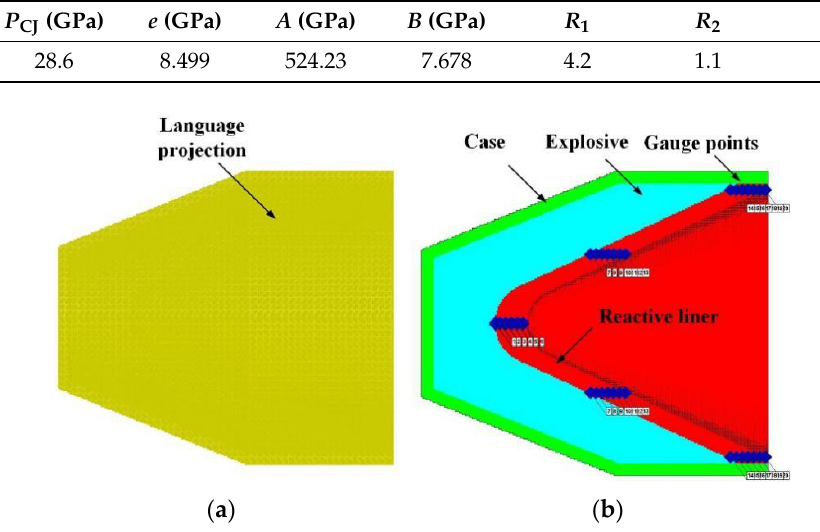
The main charge is the 8701 explosive, and its EOS is expressed by the JWL equation. Table 3 represents the parameters of 8701. The simulation model is shown in Figure 1. Table 3. JWL EOS parameters of the 8701 explosive.